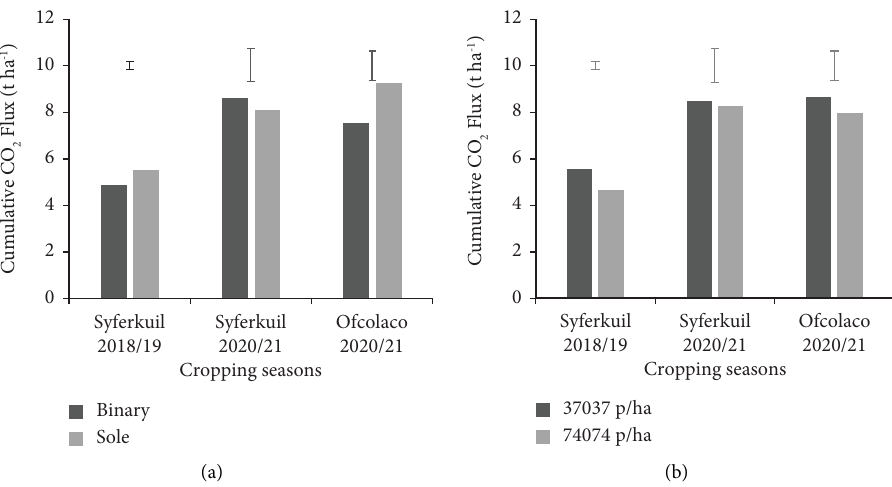
Figure 13: Cumulative CO 2 emission rates in binary and sole cultures (a) as well as low (37037 p/ha) and high (74074 p/ha) population density (b) at Syferkuil and Ofcolaco during the 2018/19 and 2020/21 cropping